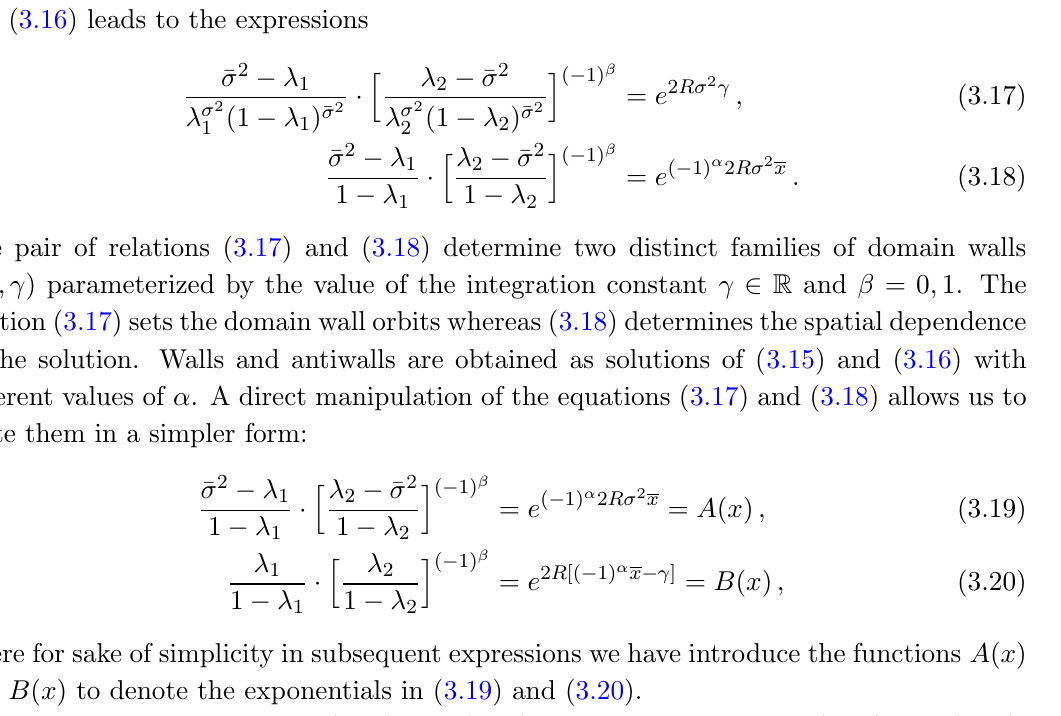
Figure 4 . Orbits for several members of the family K ( q;a;b;c ) (right) graphically represented in sphero-conical